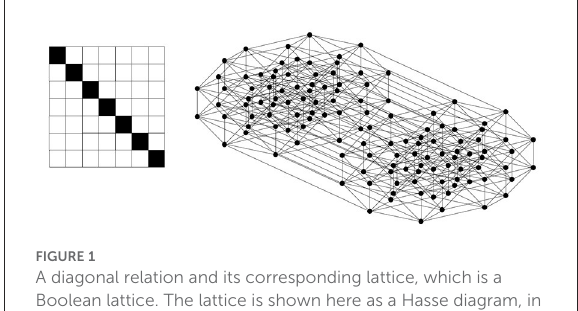
FIGURE1 A diagonal relation and its corresponding lattice, which is a Boolean lattice. The lattice is shown here as a Hasse diagram, in which the elements of the lattice (a subset of D ) are represented by black circles, and if one element is smaller than another element (i.e., one set is included in the other) and no element exists between them, then they are connected by a line, and the larger one is shown above the smaller